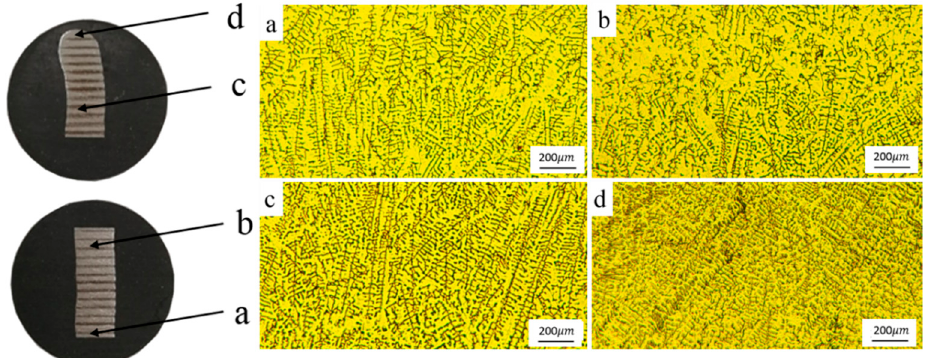
Figure 14. Longitudinal section of the inclined rods and microstructure of different positions of inclined